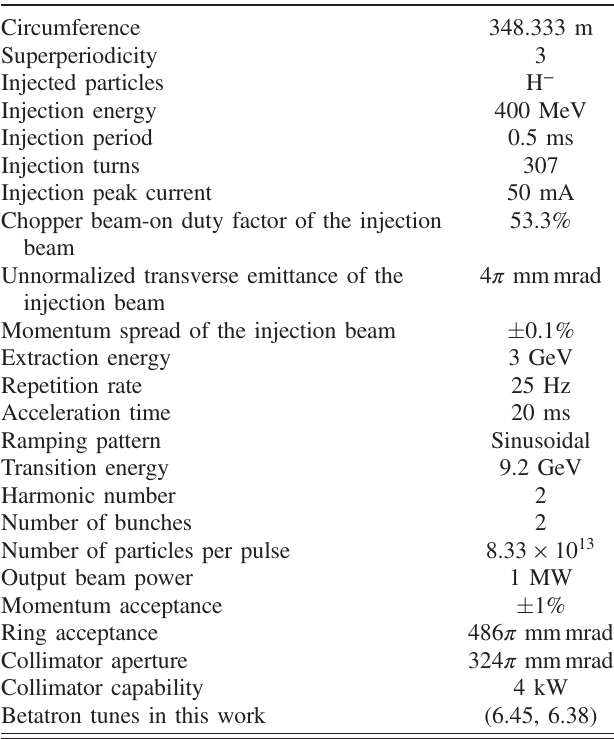
TABLE I. RCS design